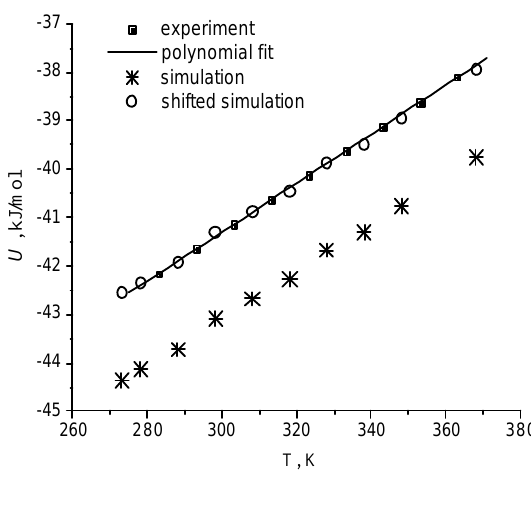
Figure 5. Temperature dependence of the density configurational potential energy of water The shifted simulation curve is shifted up by 1.8